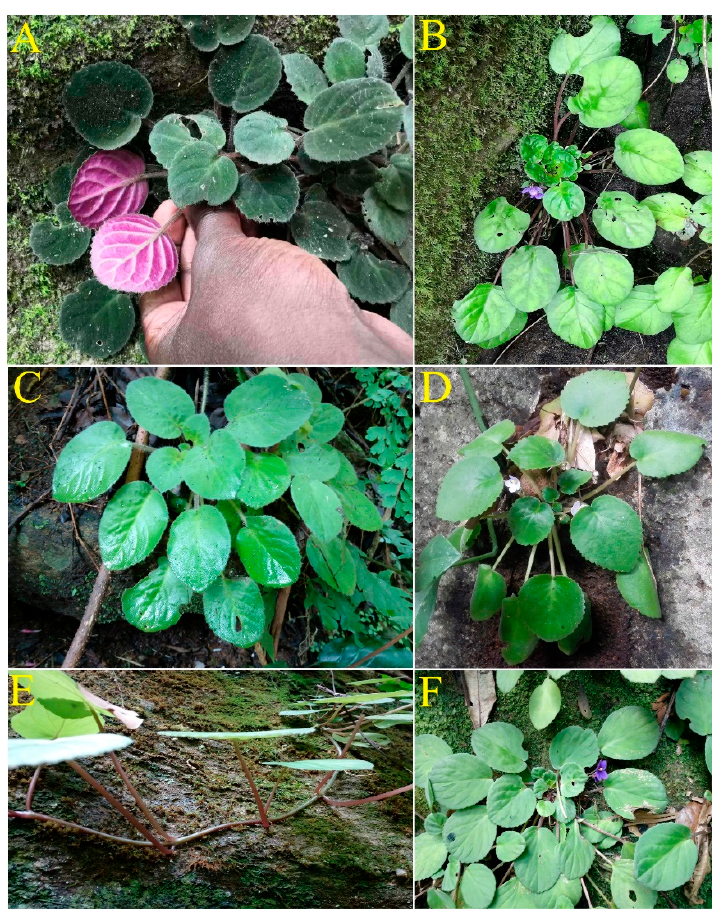
Figure 7. Morphological heterogeneity in Streptocarpus ionanthus ; ( A ) Str. ionanthus subsp. velutinus , ( B ) Str. ionanthus subsp. orbicularis , ( C ) Str. ionanthus subsp. grandifolius , ( D ) Str. ionanthus subsp. rupicola , ( E ) Str. ionanthus subsp. grotei (trailing habit) and ( F ) Str. ionanthus subsp. grotei (rosulate habit).